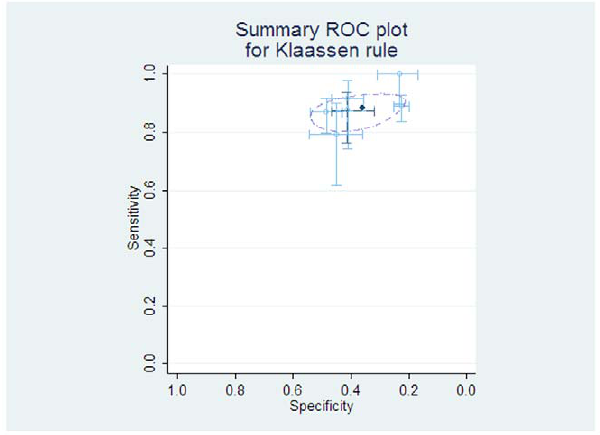
Figure 2. Individual and pooled diagnostic test accuracy of ‘Klaassen’ rule. The ROC space plots show each study estimates of sensitivity and specificity as a marker at the point estimate, with 95% confidence intervals demonstrated by lines. In reading such graphs, tests with a better discriminatory ability fall in the top left corner of the plot, and non-discriminatory tests fall on a 45 u line between the bottom left and top right. The light lines and circles represent individual studies, with the darker dashed lines showing the study from which the rule was derived. The dark circle is the pooled estimate of sensitivity and specificity, and the dashed ellipse represents the bivariate 95%